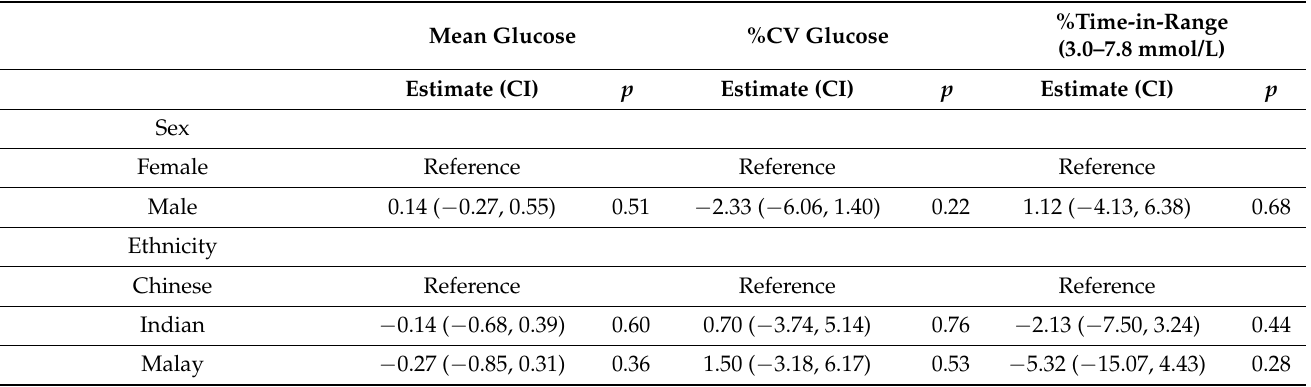
Table 2. Associations between baseline characteristics and glucose monitoring metrics over seven